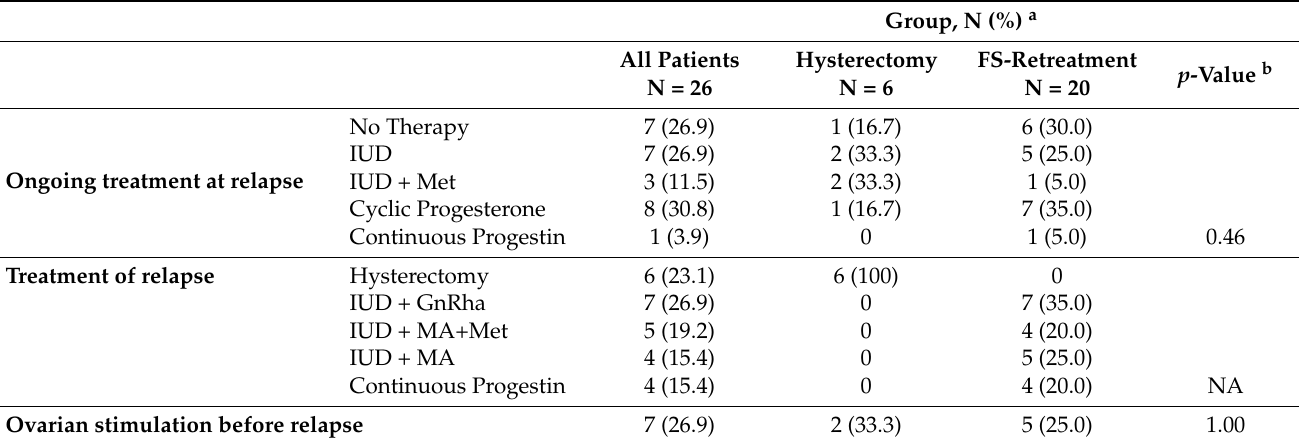
Table 2. Ongoing treatment at relapse and treatment of relapse; statistics for the groups hysterec- tomy and FS-retreatment.